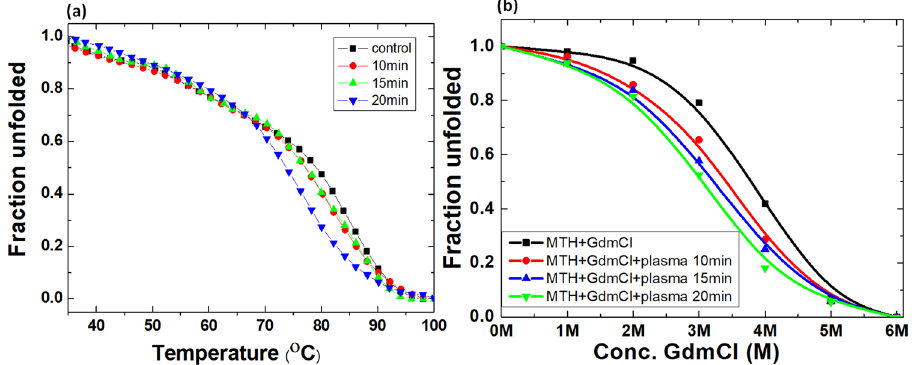
Figure 3. ( a ) Thermal denaturation and ( b ) chemical denaturation of MTH before (“control”) and after plasma treatment for different